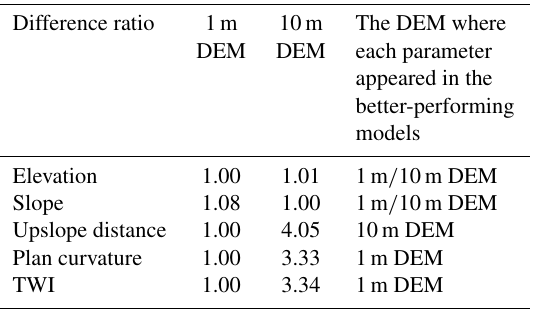
Table 8. Topographic value difference ratio between the 1 and 10m resolution DEMs (medians). The right column shows with which DEM, 1 or 10m, each topographic parameter appeared in the best- performing model. Difference ratio 1m 10m The DEM where DEM DEM each parameter appeared in the better-performing models Elevation 1.00